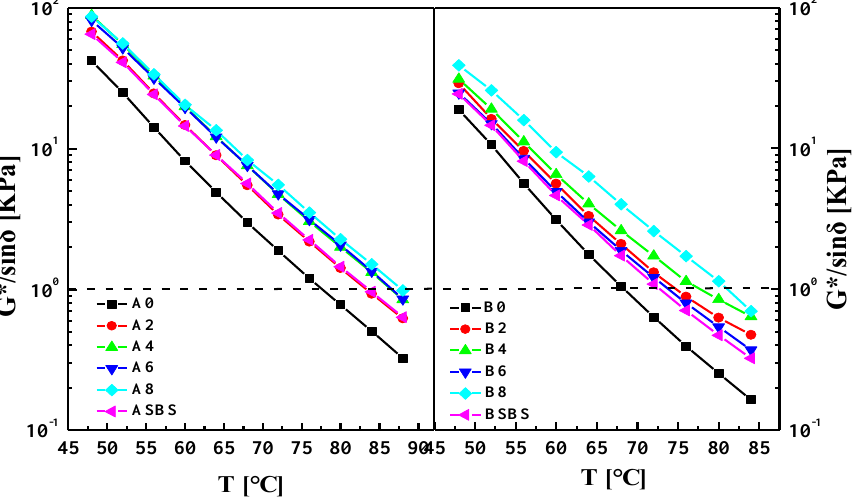
Figure 4. E ff ects of temperature on the rutting factor of the base and SBS-latex-modified Figure 4. Effects of temperature on the rutting factor of the base and SBS-latex-modified asphalts . Table 2. Failure temperature and fatigue temperature of all asphalt samples.